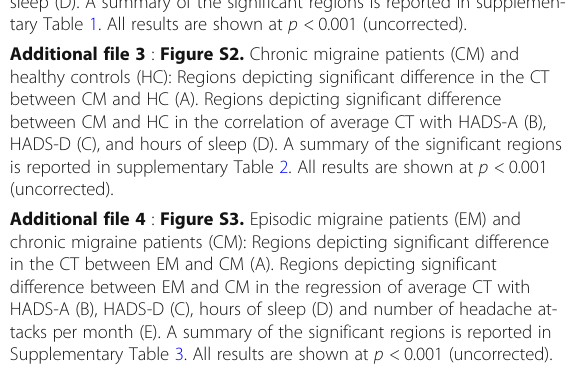
sleep (D). A summary of the significant regions is reported in supplemen- tary Table 1. All results are shown at p < 0.001 (uncorrected). Additional file 3 : Figure S2. Chronic migraine patients (CM) and healthy controls (HC): Regions depicting significant difference in the CT between CM and HC (A). Regions depicting significant difference between CM and HC in the correlation of average CT with HADS-A (B), HADS-D (C), and hours of sleep (D). A summary of the significant regions is reported in supplementary Table 2. All results are shown at p < 0.001 (uncorrected). Additional file 4 : Figure S3. Episodic migraine patients (EM) and chronic migraine patients (CM): Regions depicting significant difference in the CT between EM and CM (A). Regions depicting significant difference between EM and CM in the regression of average CT with HADS-A (B), HADS-D (C), hours of sleep (D) and number of headache at- tacks per month (E). A summary of the significant regions is reported in Supplementary Table 3. All results are shown at p < 0.001